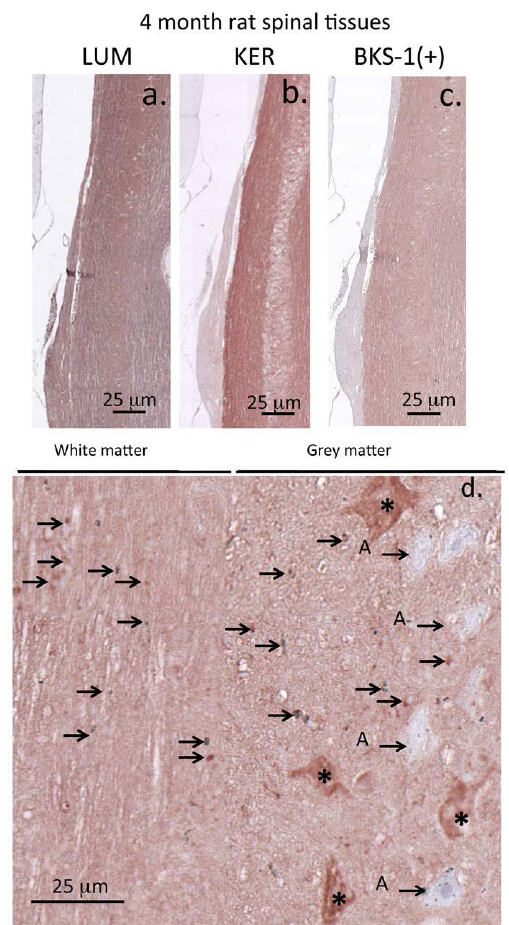
Figure 4. Immunolocalization of keratocan ( a ), lumican ( b ), and BKS-1 ( + ) KS neo-epitope ( c ) in 4 month old rat spinal tissue shows them to be widely distributed throughout the spinal cord. A higher power image of BKS-1(+) shows reactivity prominently localized throughout the spinal cord extracellular matrix and also labeled glial cells and neurons. ( d ) Glial cells are arrowed and motor neurons labeled with an asterisk, astrocytes (A) are labeled with a small arrow. Scale bars 100 μm. Chromogen NovaRED.